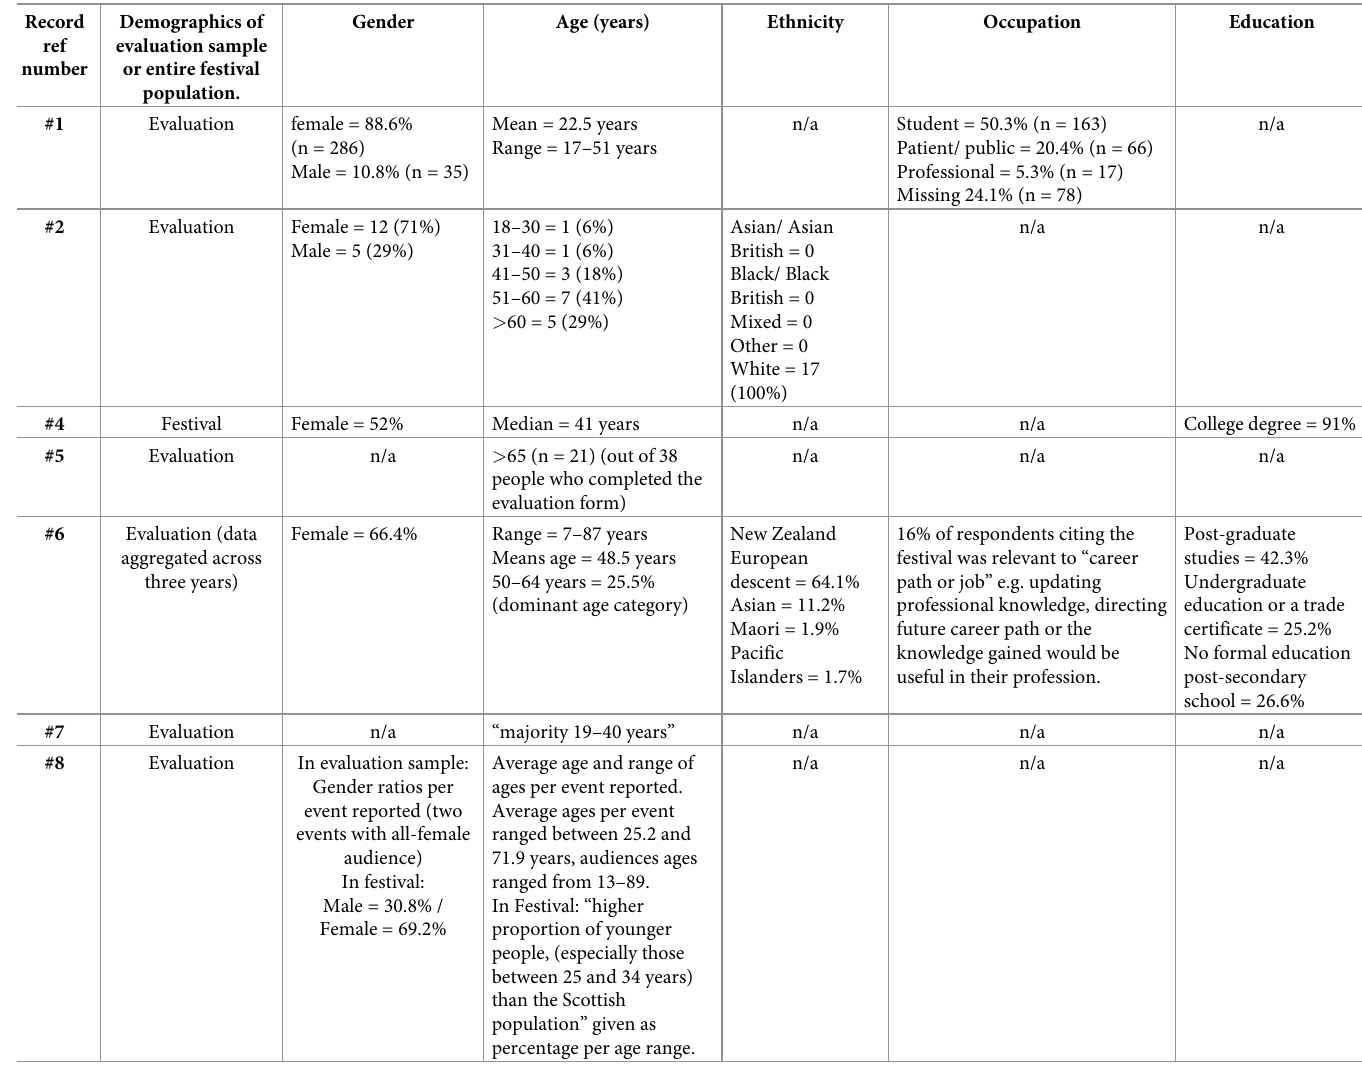
Table 3. Demographic data for studies reporting